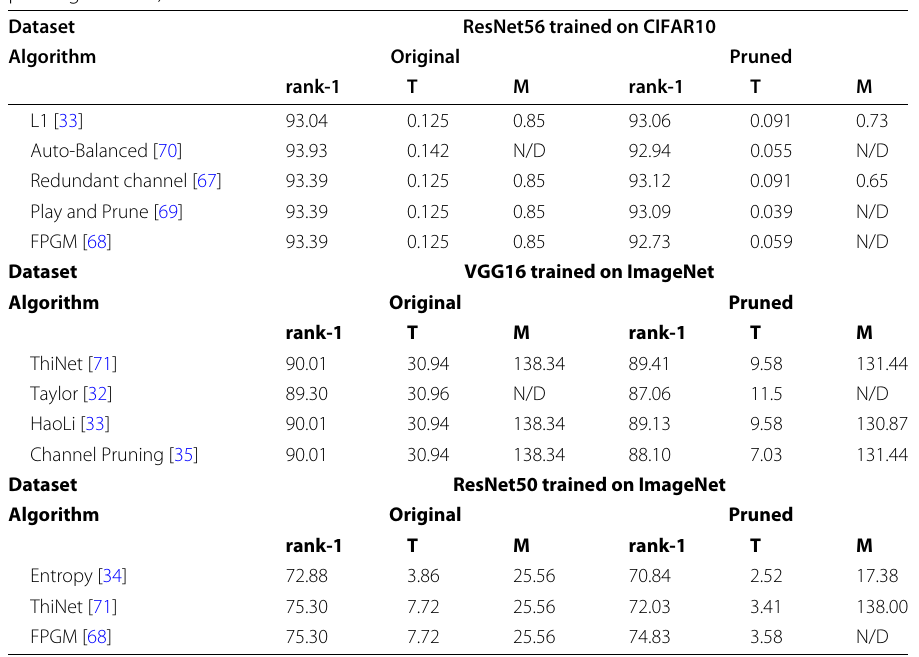
Table 3 Performance of pruning techniques from the literature in terms of rank-1 accuracy and computational complexity (memory(M): number of parameters and time (T): time required for one forward pass). To ease comparison, we include the out results produced with ThiNet (channel pruning